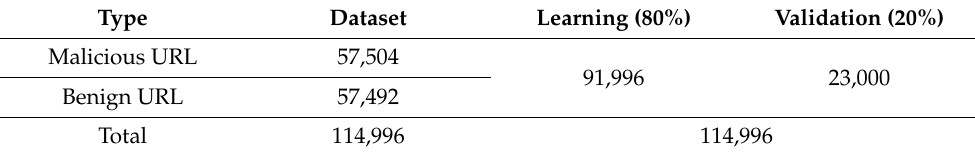
Table 2. Dataset Composition.